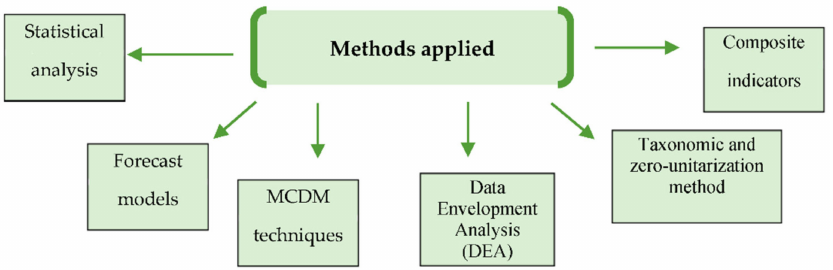
Figure 1. The variety of methods used for the analysis of target